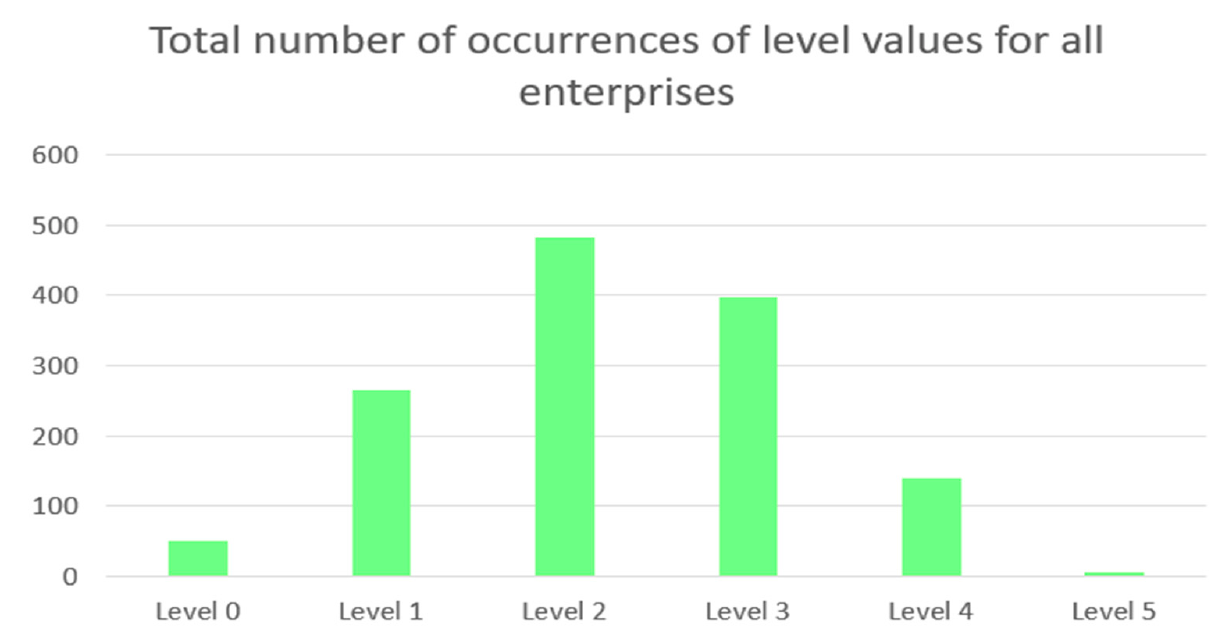
Figure 3. Average values of subdimension levels of all enterprises.